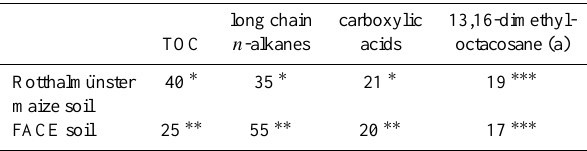
Table 3. Turnover time estimates (in years) for TOC, long numbered carboxylic acids ( n C 22 − n C 26 ) and branched GDGT- derived 13,16-dimethyloctacosanes based on (natural) labelling ex- periments in the Rotthalm¨unster maize soil and the FACE soils (a in Fig.